Question: What style of plot is this figure drawn as?
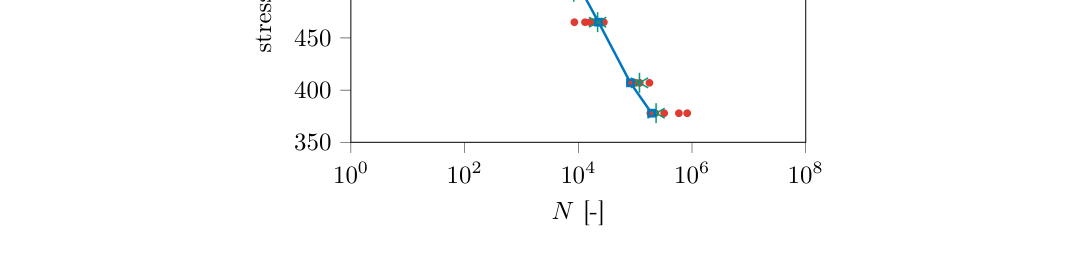
Answer: line